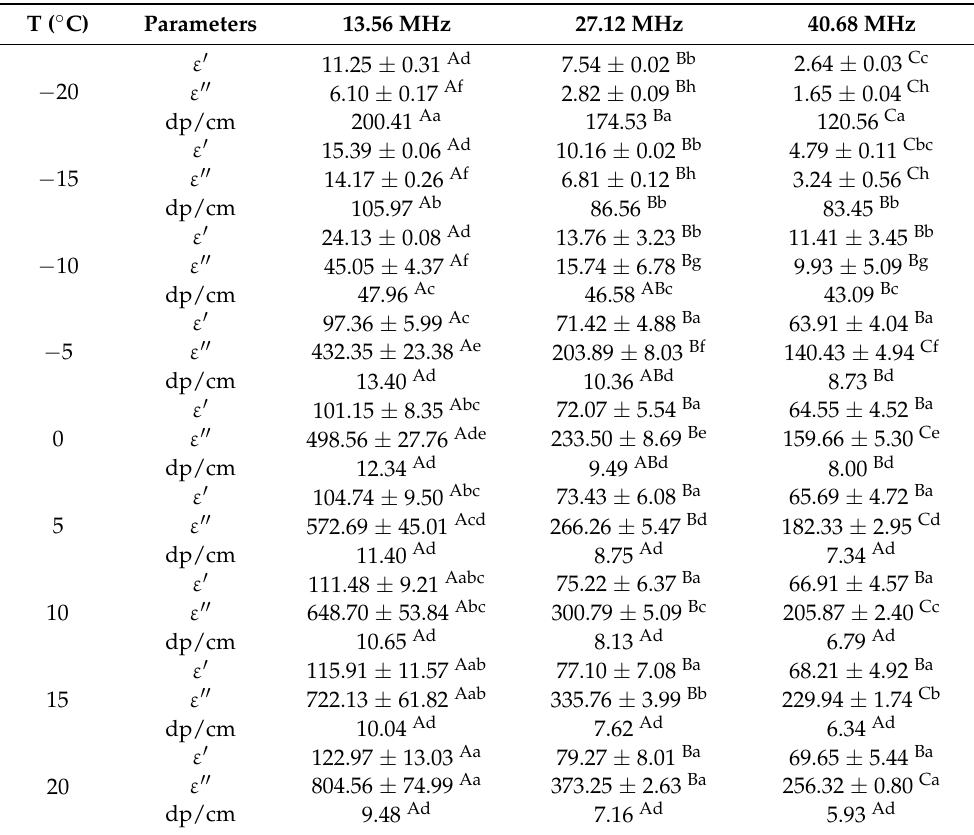
Table 1. Dielectric properties and penetration depth ( dp ) of salmon at 13.56, 27.12, and 40.68 MHz and temperatures between − 20 and 20 ◦